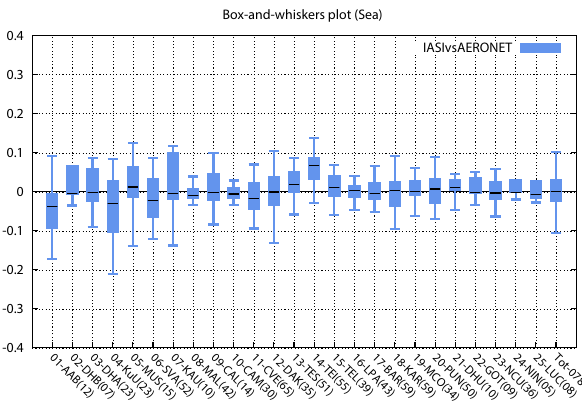
Figure 3. Box-and-whiskers plot (ends of the whiskers exclude the outliers) for the difference between IASI and AERONET 500nm coarse-mode AOD (scaled by the site ratio as explained in Sect. 3) over oceanic regions. Sites are identified by their number and code in Table 2, followed by the number of items. Last box marked “Tot”: overall